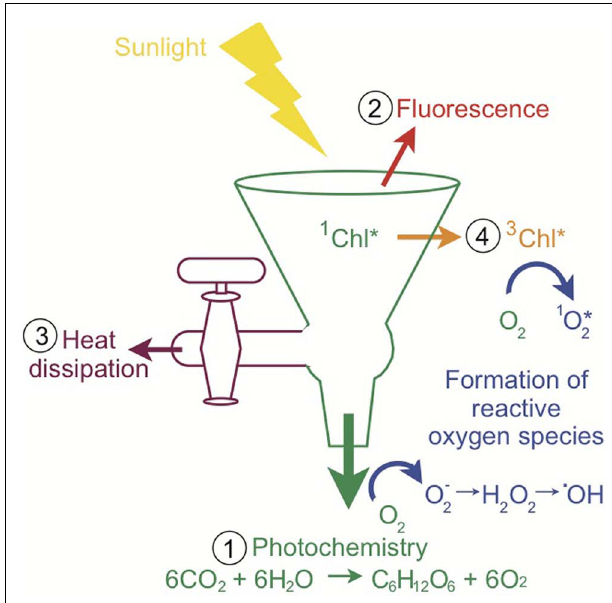
FIGURE 3 | Pathways of light energy utilization by Symbiodinium . The funnel scheme of the photosynthetic apparatus depicts the possible fates of absorbed light.When sunlight is absorbed by chlorophyll, the singlet-state excitation of chlorophyll ( 1 Chl*) is formed and the excitation energy can be (1) used to drive photochemistry, (2) re-emitted as fluorescence, (3) dissipated as heat (NPQ), or (4) decayed via the chlorophyll triplet state ( 3 Chl*), which produces reactive oxygen species as a by-product. Multiple types of reactive oxygen species are produced during photosynthetic electron flow.When the light exceeds what can be processed through these pathways, there is a high potential for the accumulation of reactive oxygen species and ultimately oxidative stress (inspired by Müller etal., 2001 and Demmig-Adams and Adams,